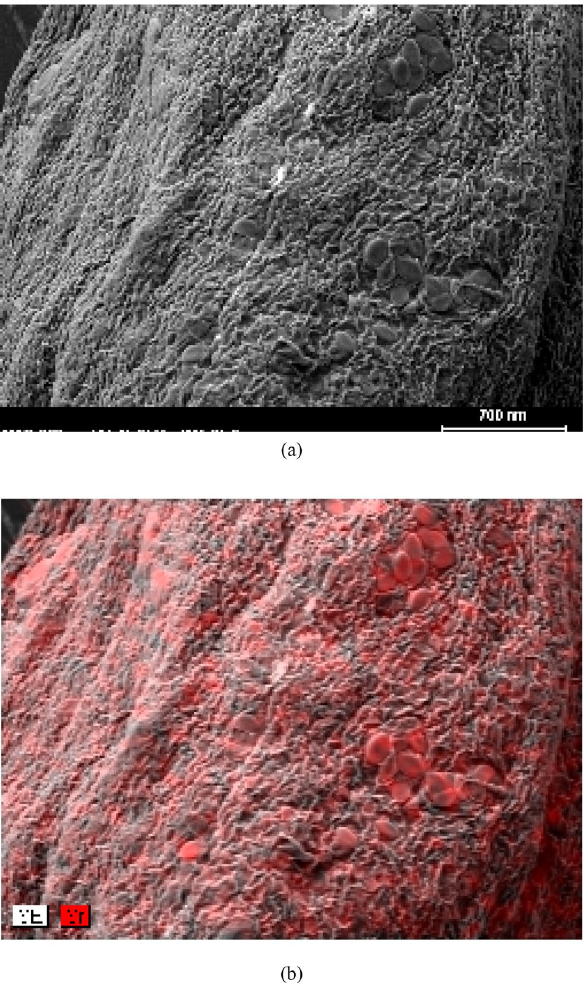
Figure 4. Element mapping of the surface of sargassum sp. earlier ( a ) and later ( b ) Sr 2+ sorption at optimal